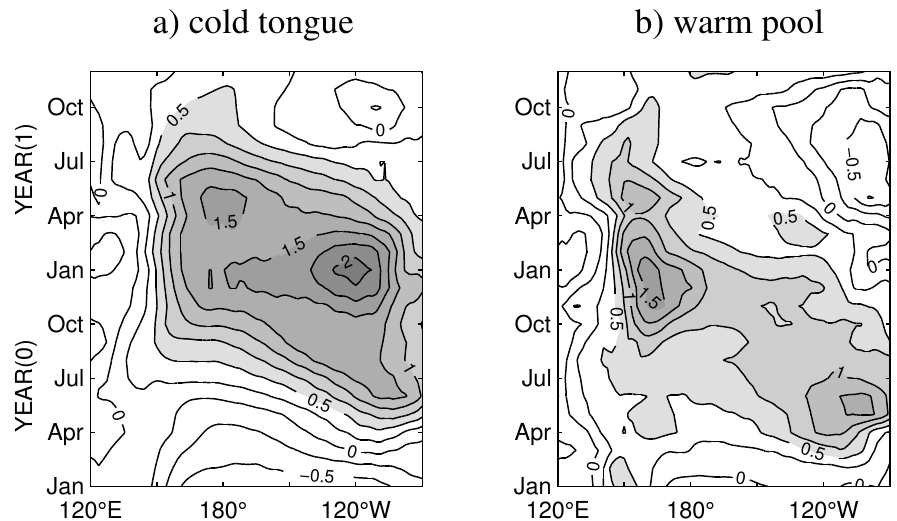
Fig. 3. Hovm¨oller plot of the composite SST anomalies on the Equator for (a) years satisfying the cold tongue conditions, and (b) years satisfying the warm pool conditions. The contour spacing is .25 ◦ C, and temperatures over 0.5 ◦ C are coloured Fig. 3. Hovm¨ollerplot of the composite SST anomalies on the equator for a) years satisfying the cold tongue conditions, and b) years satisfying the warm pool conditions. The contour spacing is 0 . 25 ◦ C and temperatures over 0 . 5 ◦ C are coloured grey.